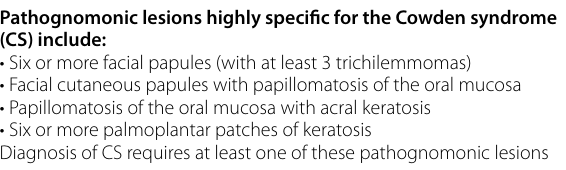
Table 2 Diagnostic criteria proposed by the International Cowden Syndrome Consortium [9, 10] Pathognomonic lesions highly specific for the Cowden syndrome (CS)